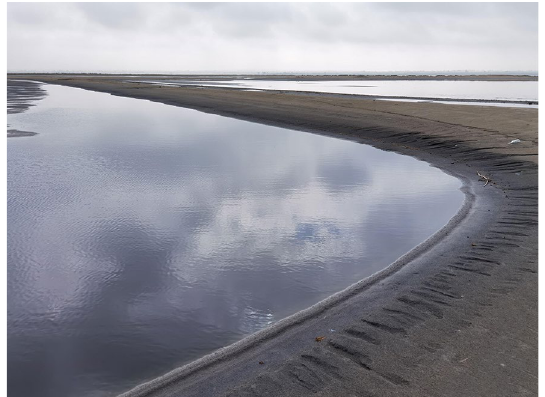
Figure 1. Arthrospira strains found in Bayannur Lake. Retrieved from: https:// www. meipi an6. cn/ 38baf 2jz.